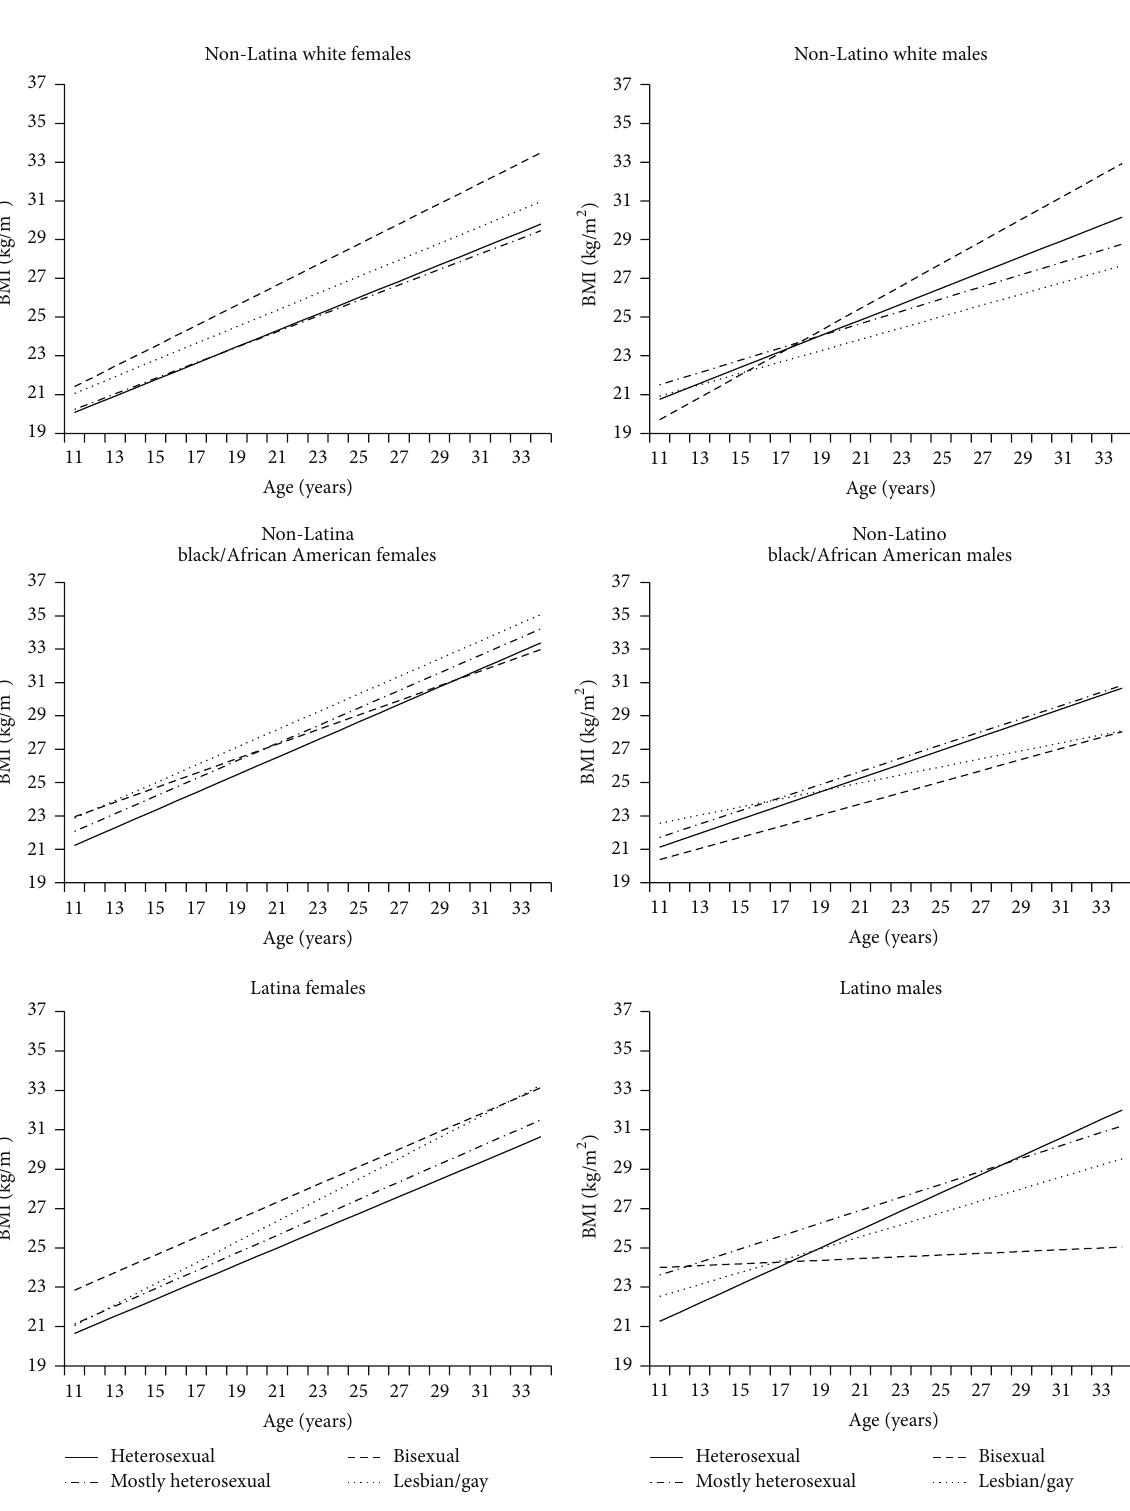
Figure 1: BMI trajectories by sexual orientation across race/ethnicity groups of adolescents and young adults in the US National Longitudinal Study of Adolescent Health, Waves I–IV